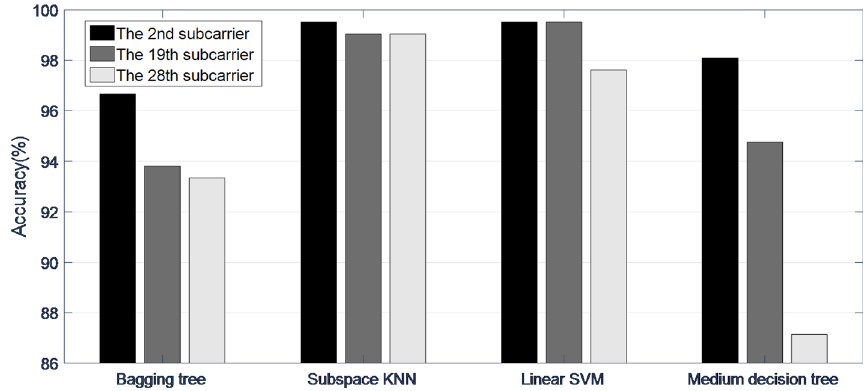
Fig. 11 Accuracy of the gesture recognition using the data of the 2nd, 19th and 28th